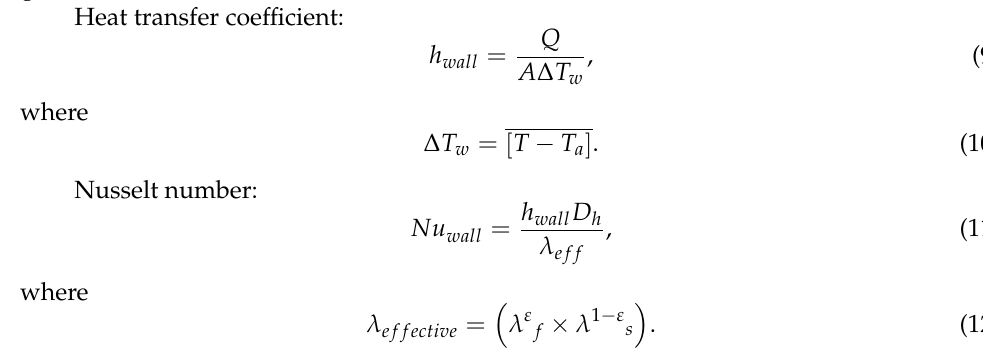
Figure 3. Sketch depicting the various thickness configurations considered in the present study: ( a ) 100% thickness, ( b ) 75% thickness, ( c ) 50% thickness and ( d ) 25% thickness. The definitions of heat transfer coefficient and Nusselt number in this study are given